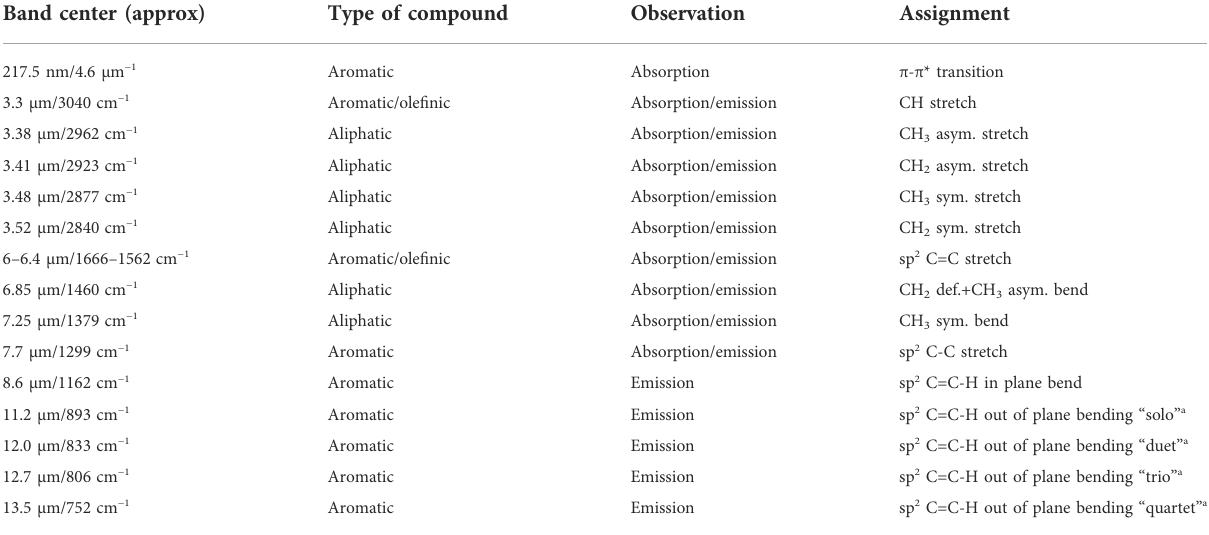
TABLE 1 Summary of characteristic spectral features of carbonaceous matter observed in the ISM. Band assignments can be found for instance in Gavilan et al. (2017), Dartois et al. (2007), Chiar et al. (2013), Allandola et al. (1989), Hudgins and Allamandola (1999), Tielens (2008), Peeters et al. (2021). The given band centers are approximate, and slightly different values can be found in the